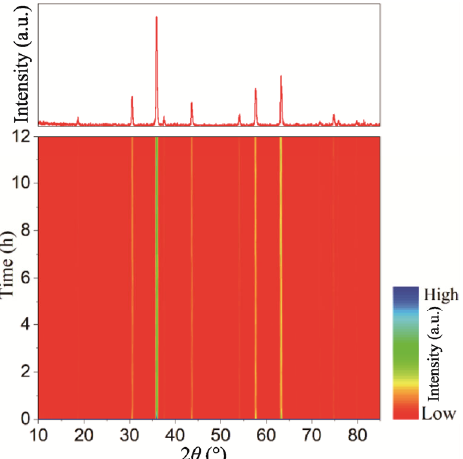
Fig. 2 In situ XRD measurements of FMCNC powder at 600 ℃ under CO 2 -containing atmosphere as a function of time. XRD pattern of the FMCNC after 12 h exposure is on the top.